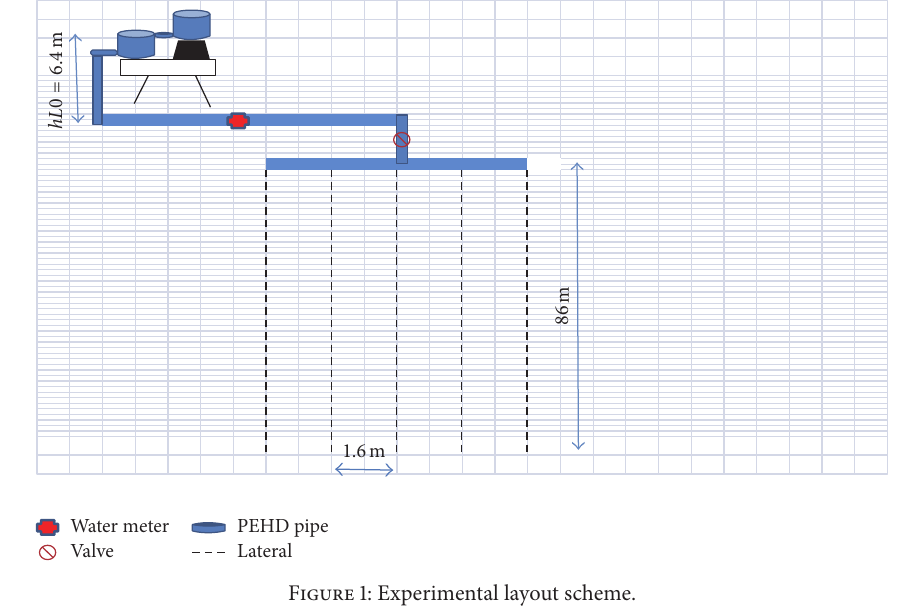
Figure 1: Experimental layout scheme.